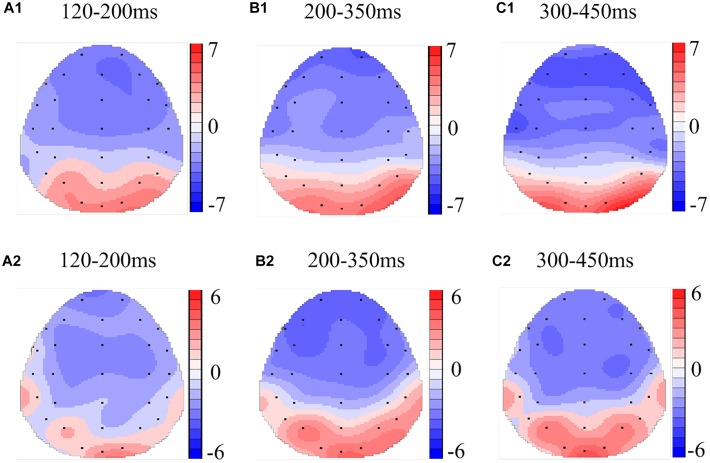
Topographic map of the differences between sleep conditions for Mismatching stimuli of working memory (A1–C2). Head plots of the paired t-test approach (two-tailed t-test, p < 0.05) map the scalp distribution of statistical differences of 36 h of total sleep deprivation (TSD) vs. 8 h time in bed (TIB) (A1–C1) and 8 h time in bed for recovery (TIBR) vs. TIB (A2–C2). Color bars indicate t-values. (A1) P200, 120–200 ms, in TSD vs. TIB. (B1) N200, 200–350 ms, in TSD vs. TIB. (C1) P300, 300–450 ms, in TSD vs. TIB. (A2) P200, 120–200 ms, in TIBR vs. TIB. (B2) N200, 200–350 ms, in TIBR vs. TIB. (C2) P300, 300–450 ms, in TIBR vs. TIB.